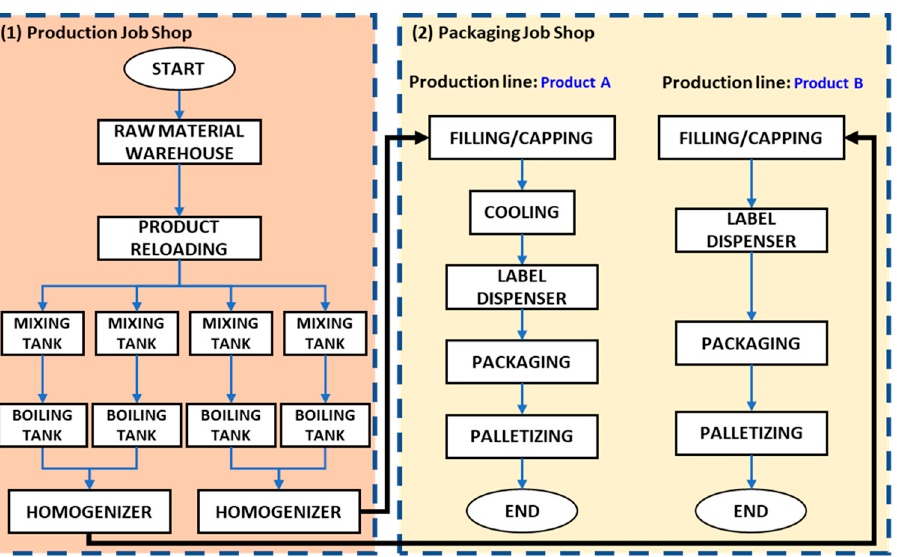
Figure 15. Proposed Layout of the Process Industry Production Line.